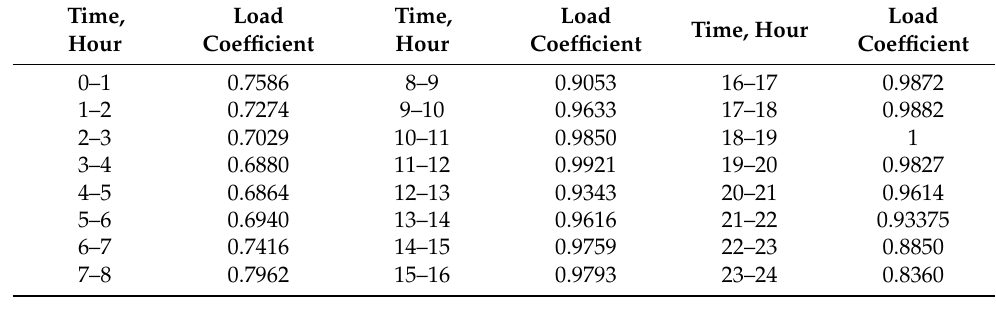
Table 2. Hourly load coefficient.